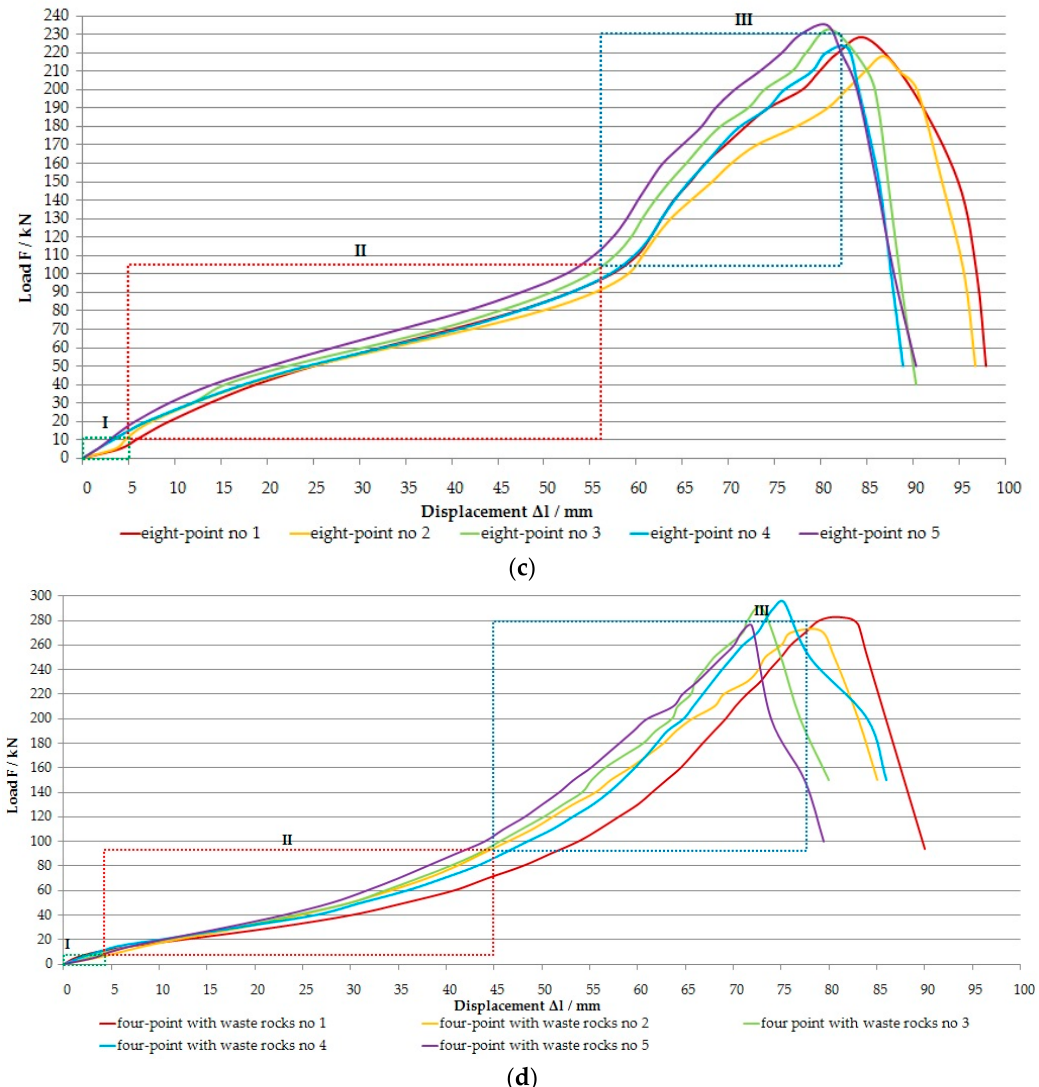
Figure 9. Load-displacement of the wooden crib models: ( a ) Four-point; ( b ) Six-point; ( c ) Eight-point; ( d ) Four-point filled with waste rocks.